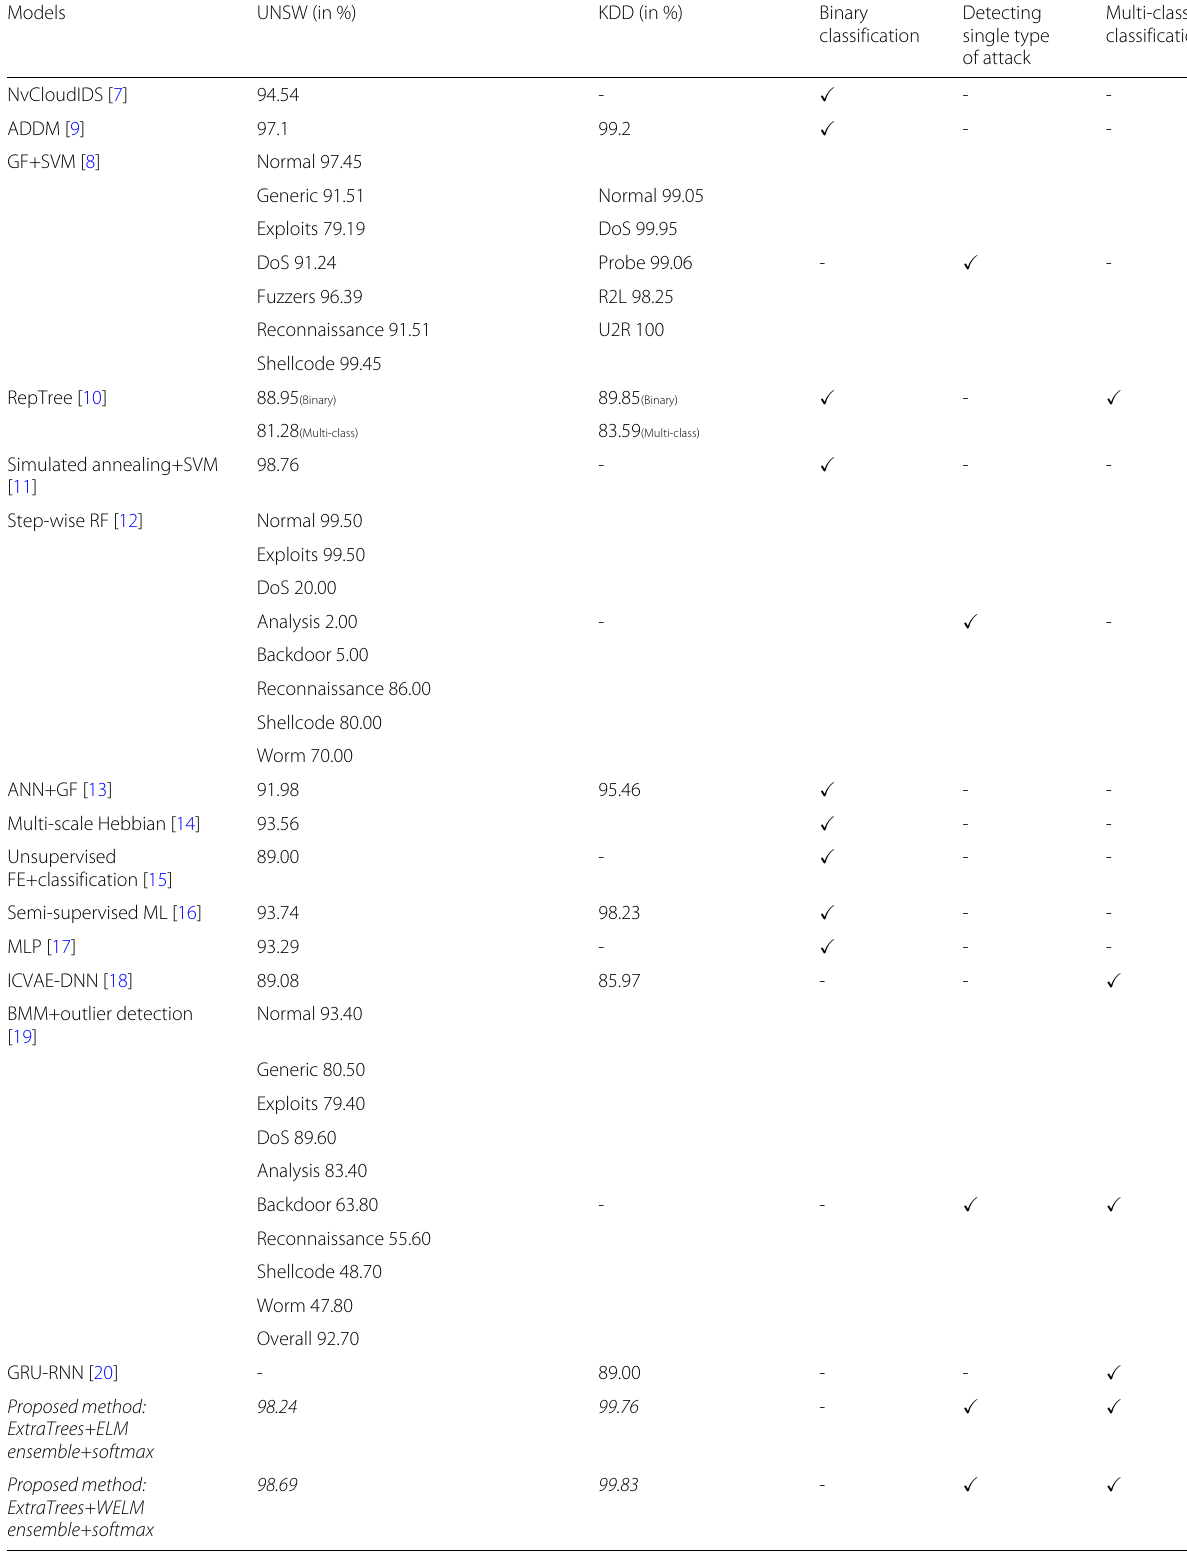
Table 1 Previous state-of-the-art ML based intrusion detection systems and the proposed method